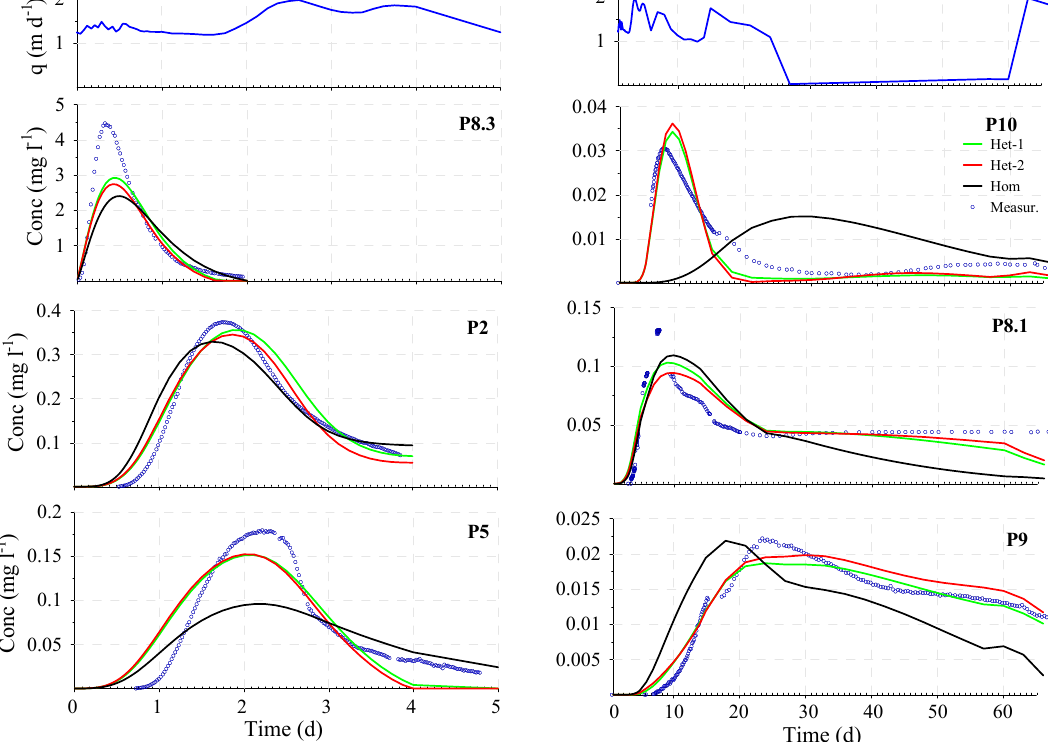
Figure 3. Top row: inflow rate to the infiltration basin; lower three rows: measured (blue circles) and calculated breakthrough curves from the piezometer monitoring of the amino-G acid concentration (mgL − 1 ) vs. time (d) using the estimated set of parameters of Het-1 (green line), Het-2 (red line), and Hom (black line). The left row displays only the first 5 days of the experiment. Note that the vertical scale is different for each monitoring